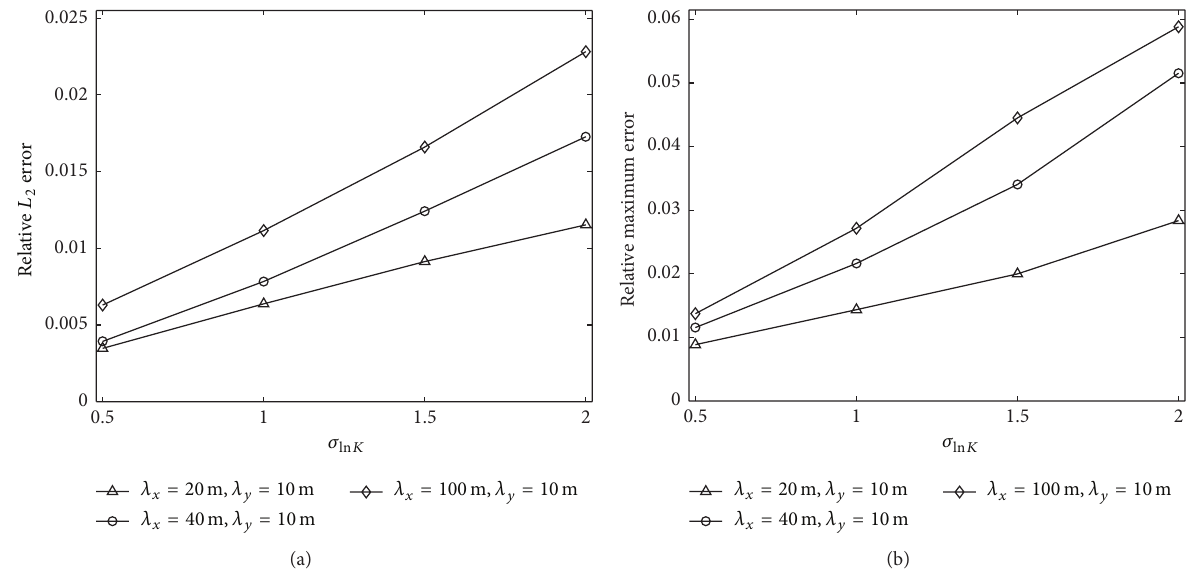
Figure 8: Relative (a) 𝐿 2 and (b) maximum errors between the fine-scale model and the new scheme for the steady flow problem with anisotropic correlation